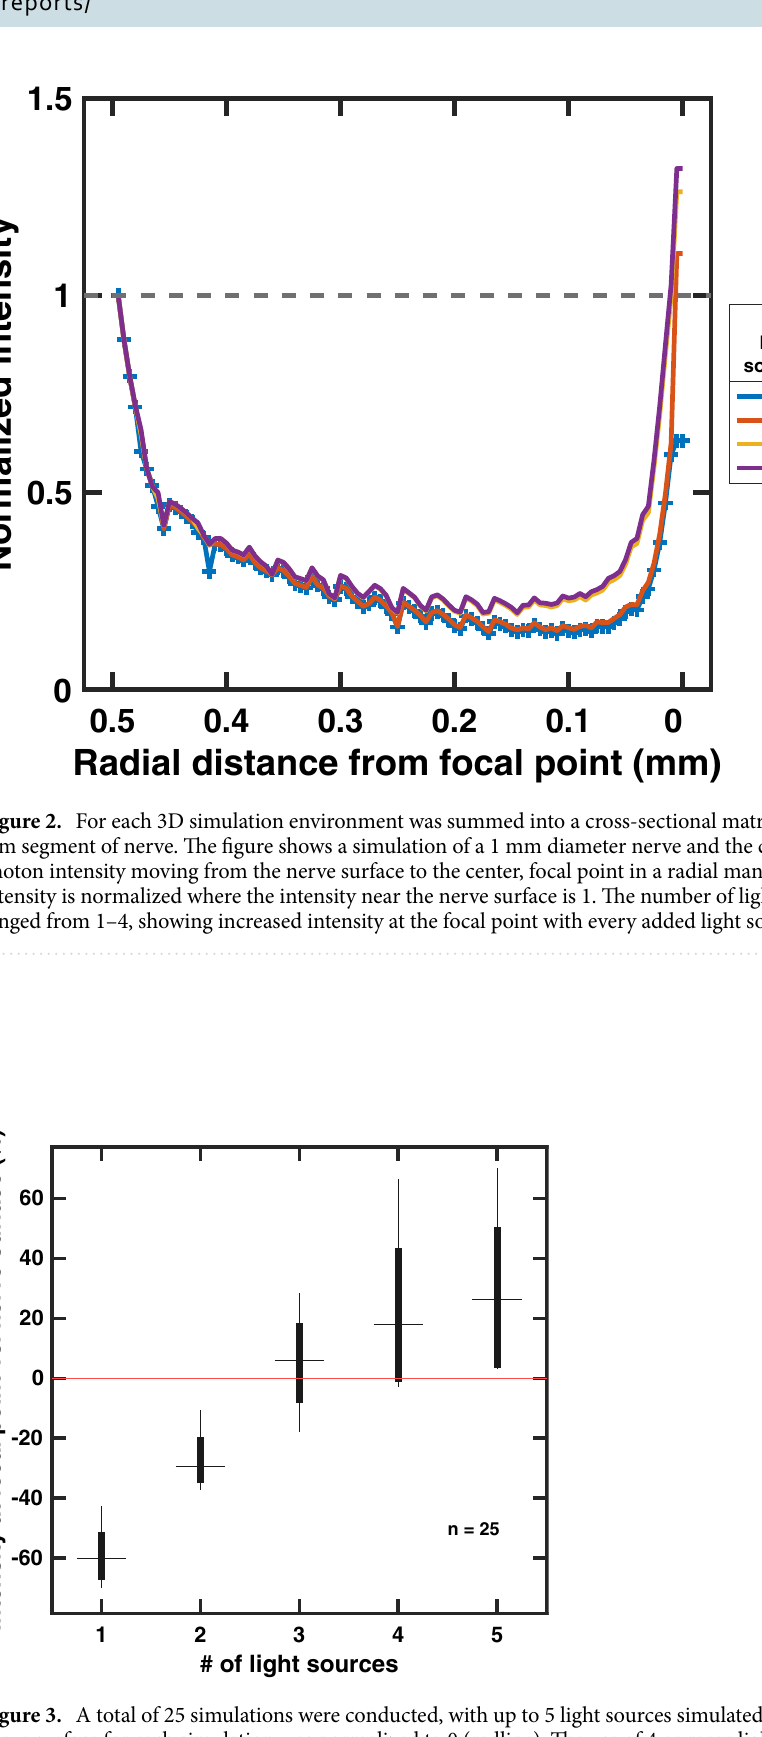
Figure 3. A total of 25 simulations were conducted, with up to 5 light sources simulated. The intensity of the nerve surface for each simulation was normalized to 0 (redline). The use of 4 or more light sources increased the intensity at the target over the nerve surface but was unreliable when using